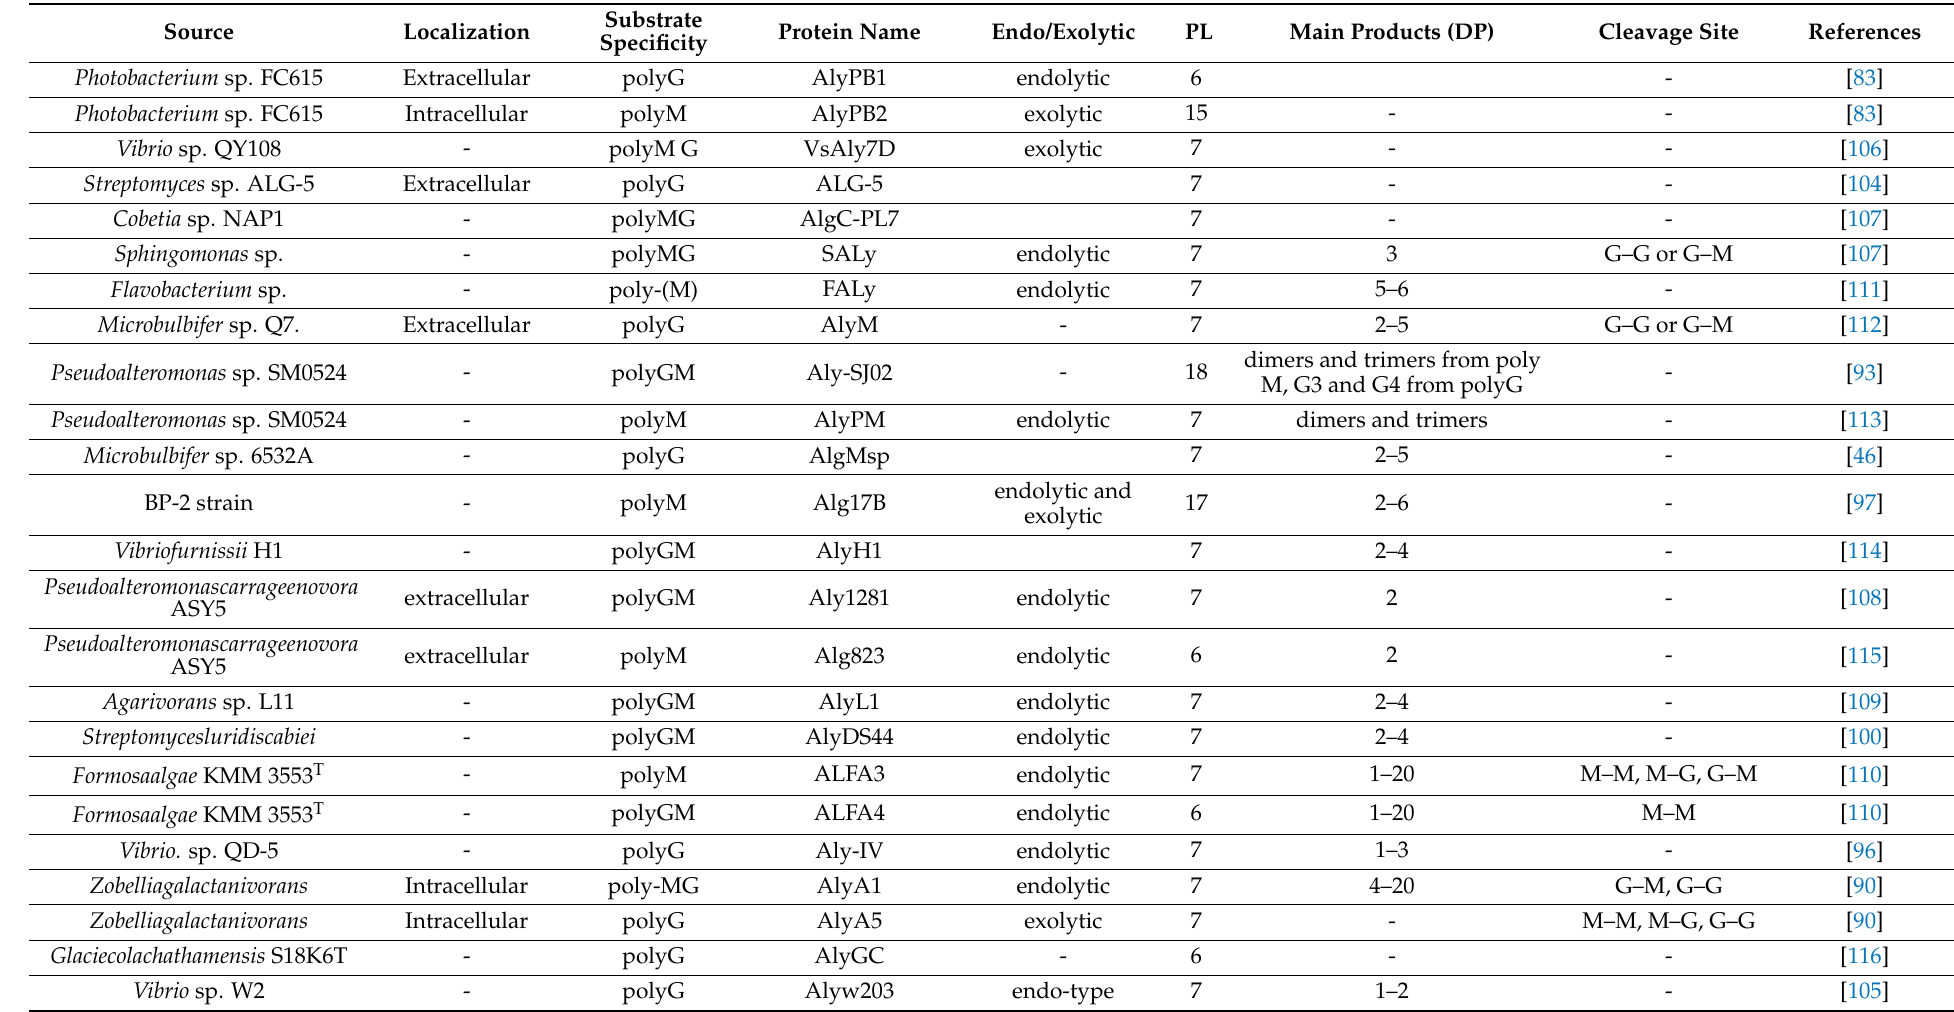
Table 1. Alginate lyases separated from various PL families of marine alginolytic